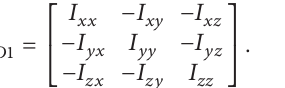
Figure 4: Orientation adjustment